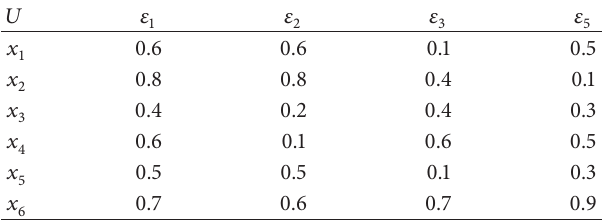
Table 4: Tabular representation of (𝐻,𝐶) .